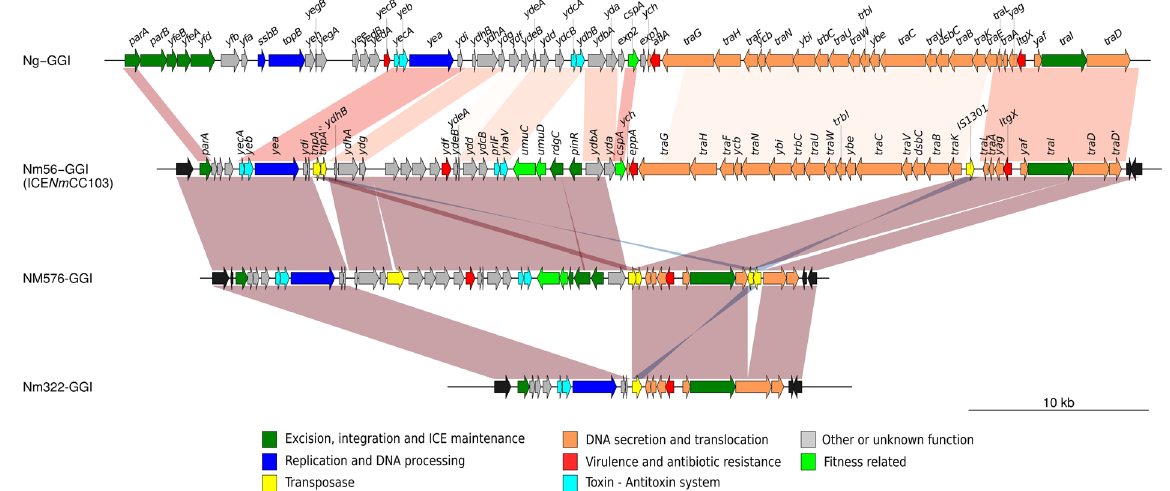
Figure 3. Genetic organization of the GGI from N . gonorrhoeae (Ng) compared with the N. meningitidis GGI-like elements characterized in this study. Schematic comparison of the GGI versions of Ng, Nm56 (ICE Nm CC103), Nm576 and Nm322 genomes. Genes are presented as arrows, with the arrowhead indicating the direction of the transcription. Black arrows indicate the chromosomal genes flanking the GGI-like elements, which are represented by colored arrows. Areas between the GGIs shaded as horizontal blocks indicate similar regions based on sequence